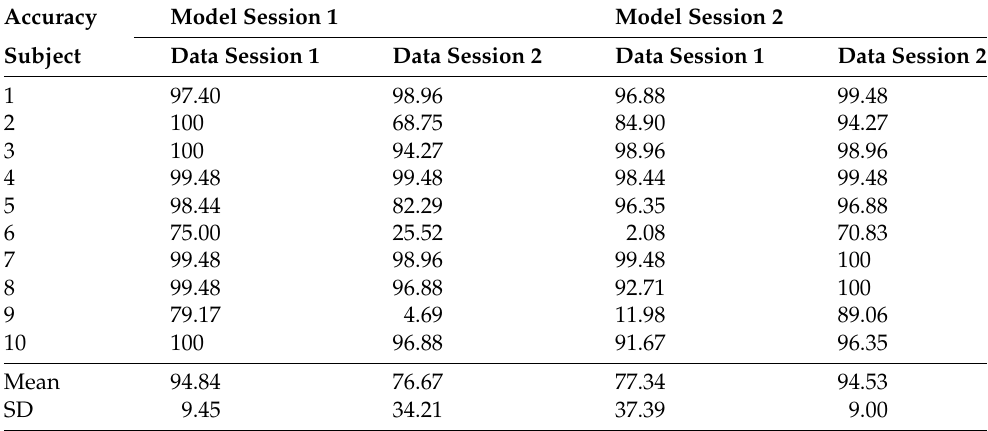
Figure 4. Cross-validation of the training EEG data across paradigms for 2.1 s time window. This fig- ure shows the accuracy of M session1 Data session2 and M session2 Data session1 tested across all participants, where e.g., the model (M) from session 1 was used to classify the session 2 training EEG data ( left side), and model (M) from session 2 was used to classify the session 1 training EEG data ( right side). Table 1. Cross sessions accuracies (%) and ITR (bits/min) results. The data of session 1 ( bl 1– bl 6) and session 2 ( Dbl 7– bl 12) were used to create the models M session 1 and M session 2 ,